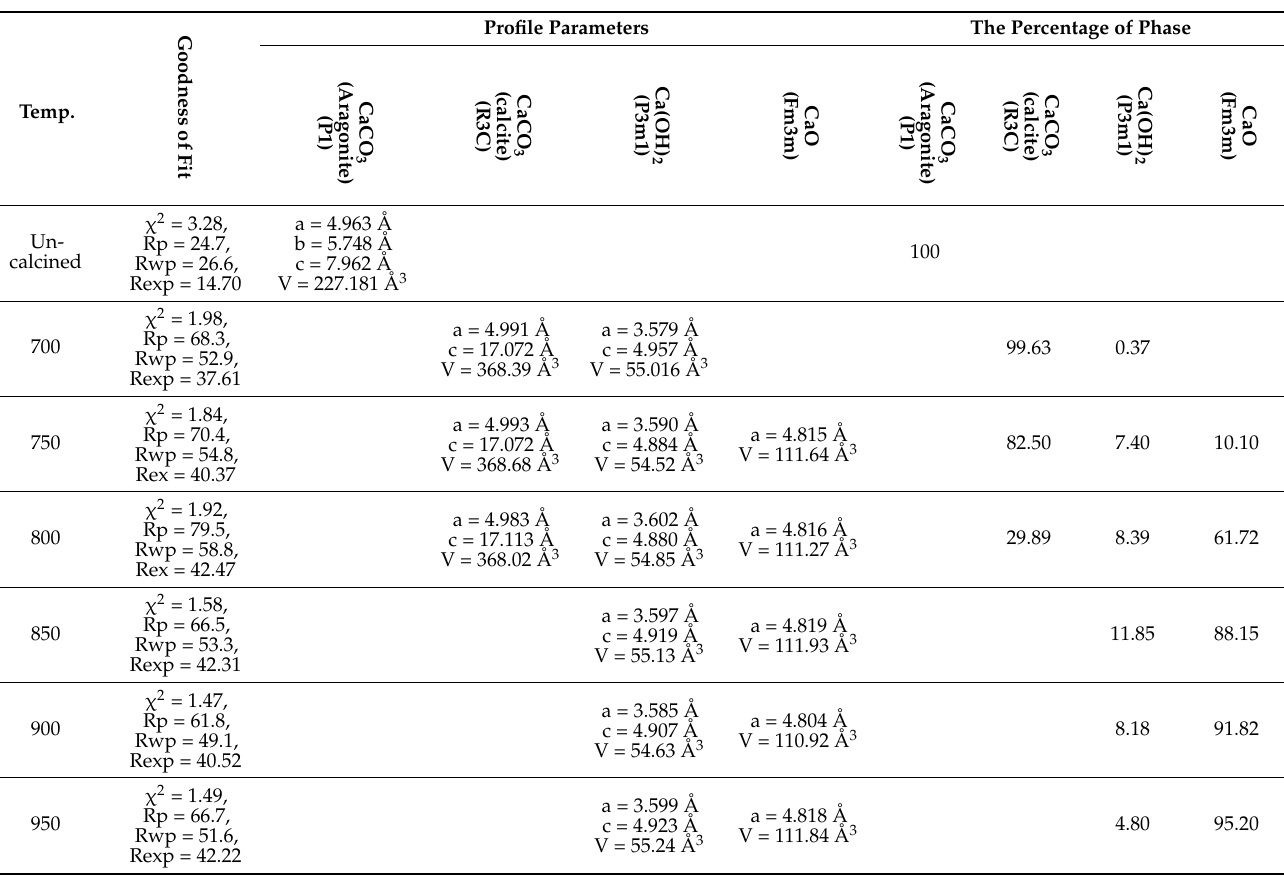
Table 1. Rietveld structural refinement results for uncalcined (natural) and calcined CS powders between 700 ◦ C and 950 ◦